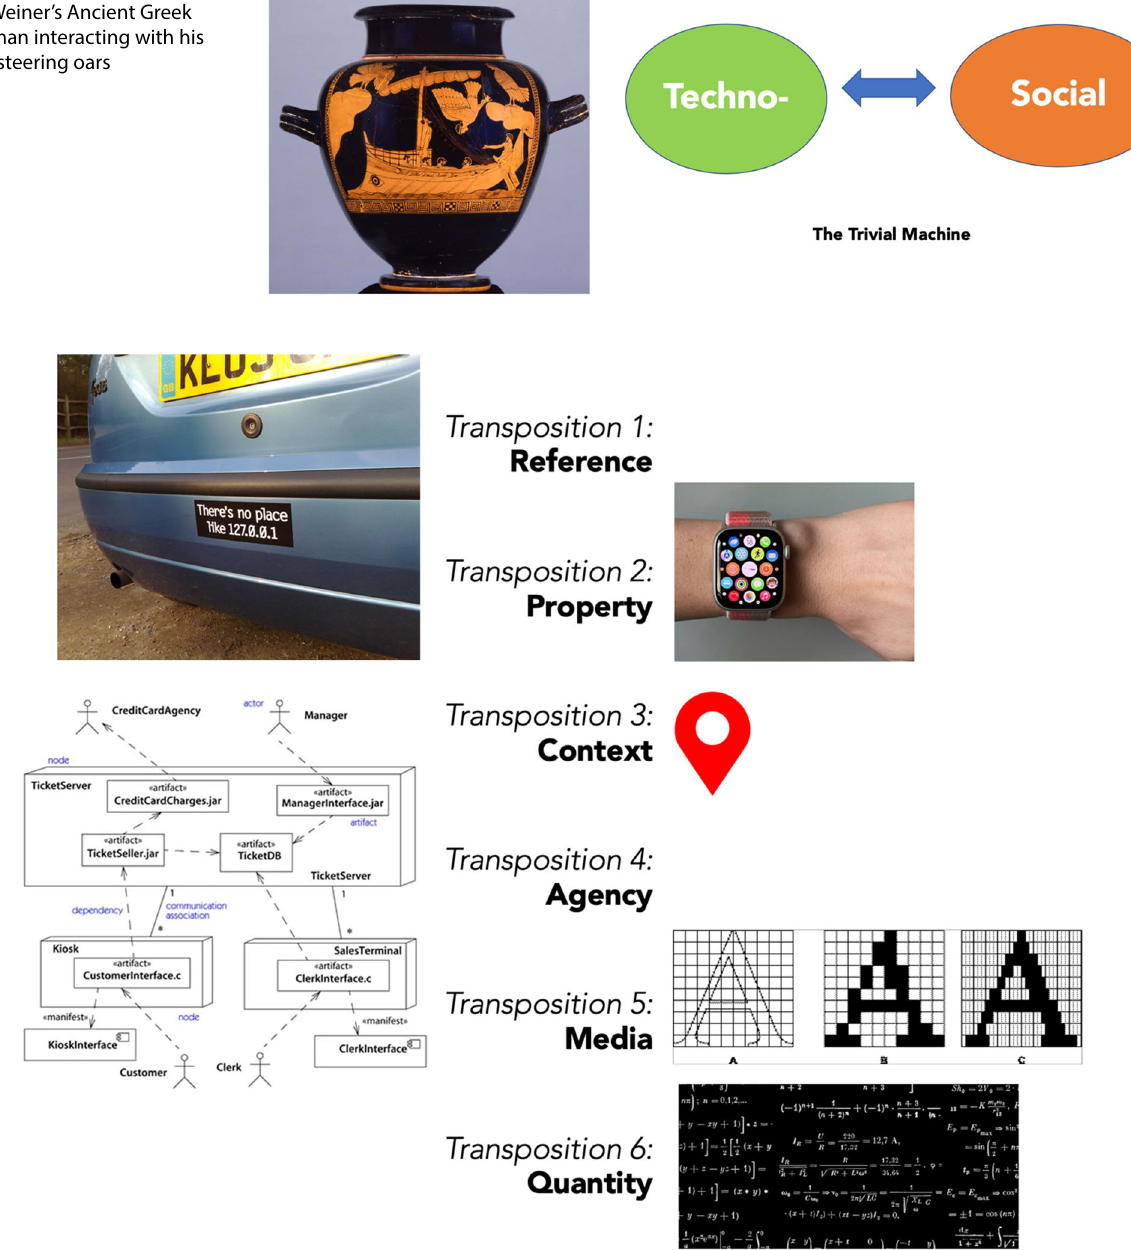
Fig. 6 Six transpositions through binary notation, with examples: reference (a URL); properties (a fitness tracker); context (a geolocation pin); agency (diagraming in Unified Modeling Language a computer-supported ticket selling, with or without a clerk); media (pixelated ren- dering of a Unicode character); quantity (mathematical formulae, for instance for statistical machine